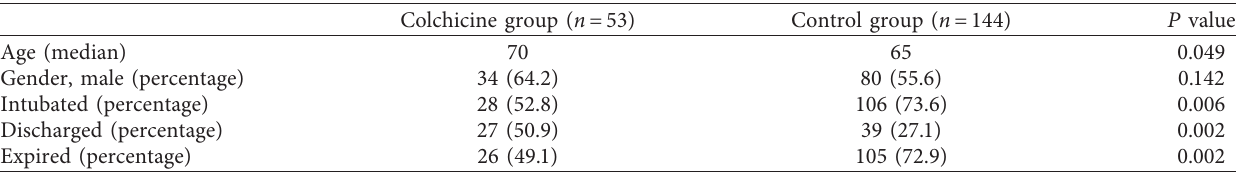
Table 1: Initial analysis on all patients who received colchicine and the patients meeting criteria for the control group, irrespective of the availability of two timepoint inflammatory markers. Age was nonnormally distributed; the Mann–Whitney U test was used to check for statistical significance. Fisher’s exact test was used to check for differences in the distribution of male patients in the two groups. The χ 2 test was used to evaluate for statistical significance of the difference in the intubated patients, patients expired, and patients discharged in the two groups.